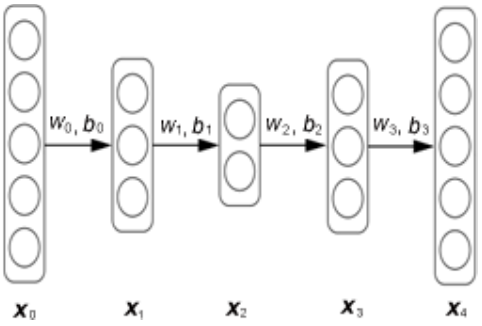
Fig. 2 A four-layer stacked denoising